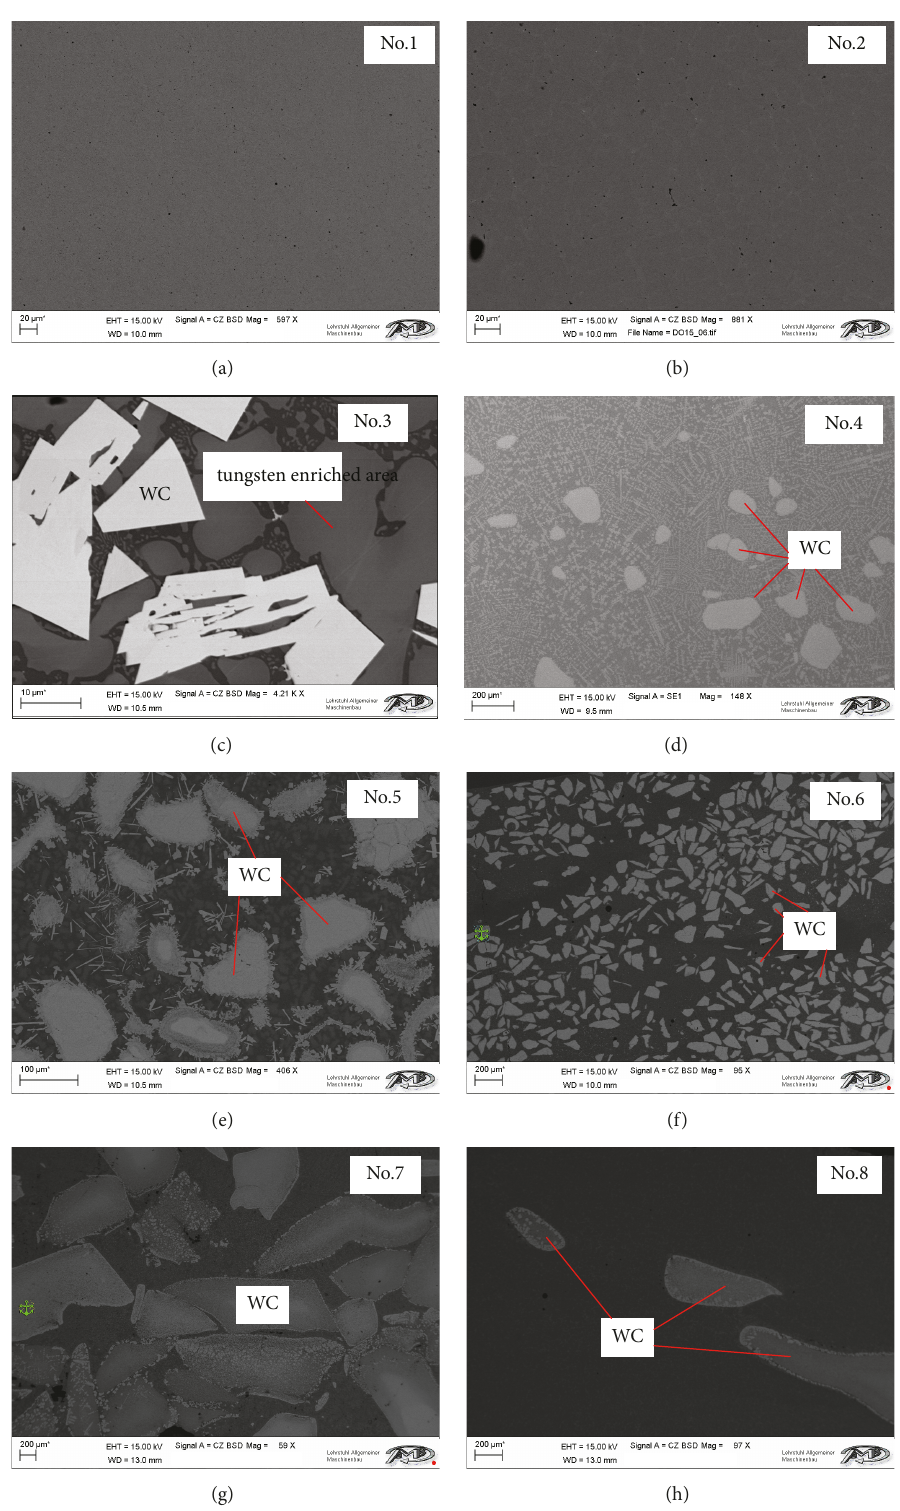
Figure 3: SEM images from hard phase including tested